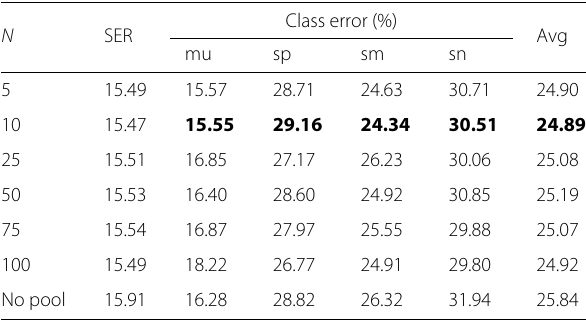
Table 6 SER, error per class and average class error for the different pooling factors ( N ) and average pooling